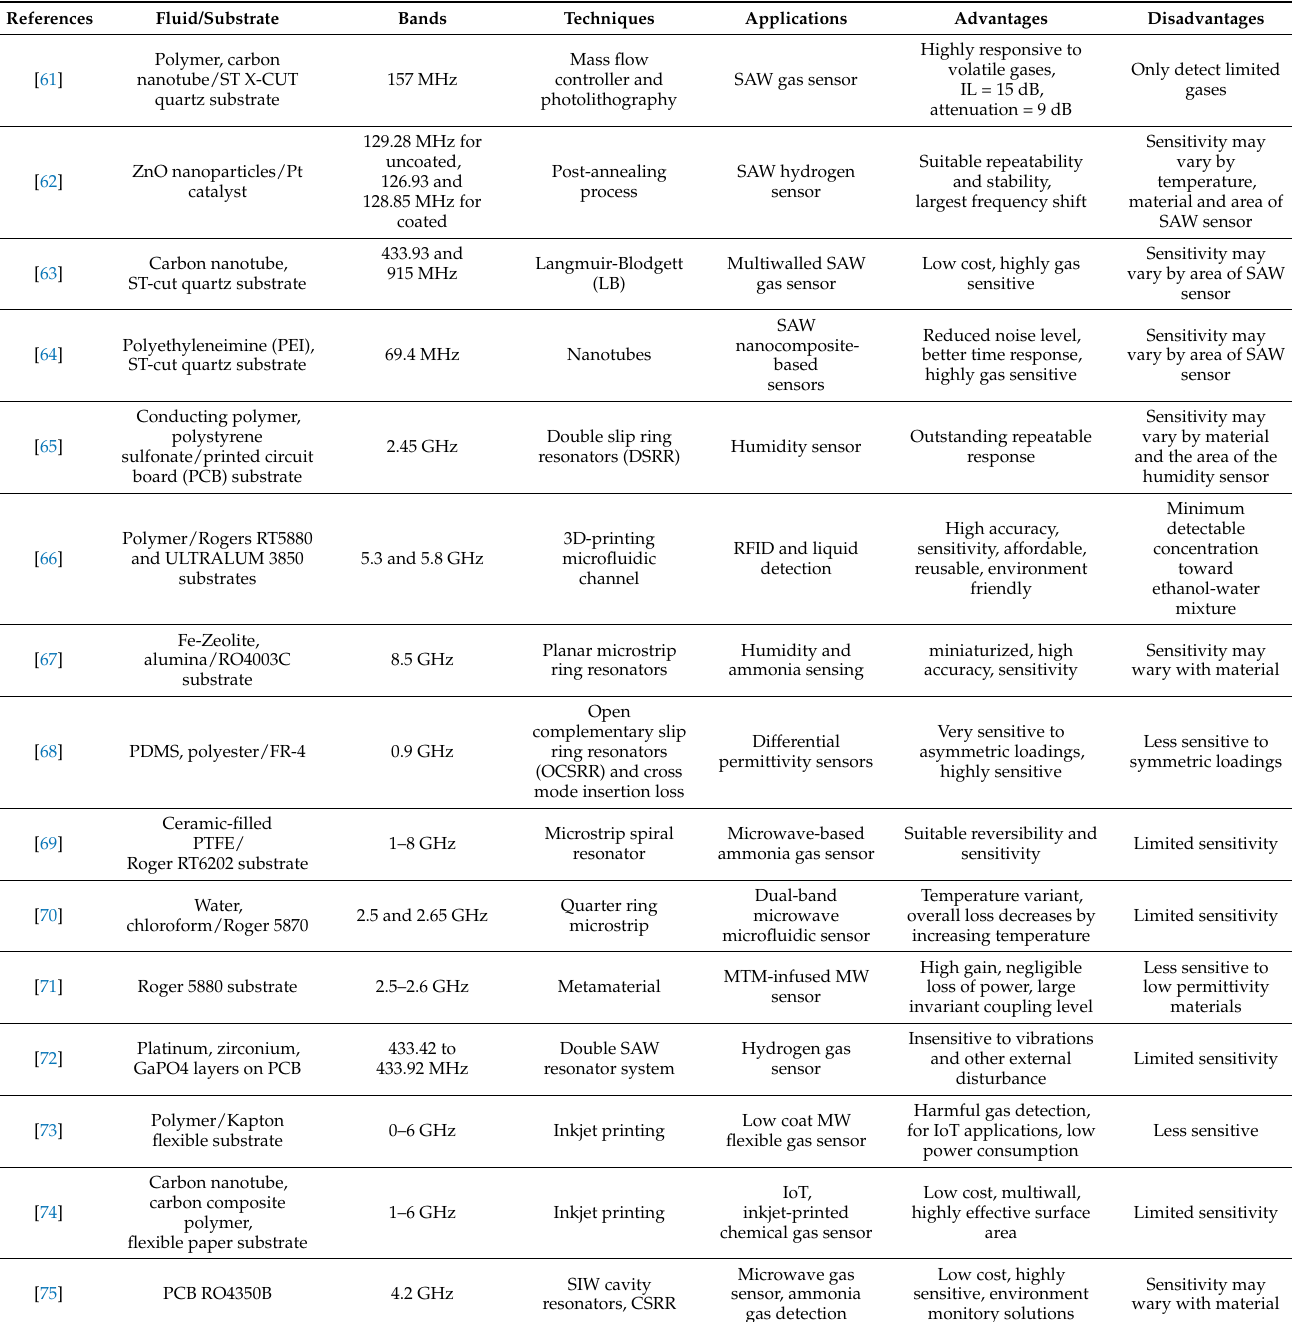
Table 5. Comparison analysis of microfluidic